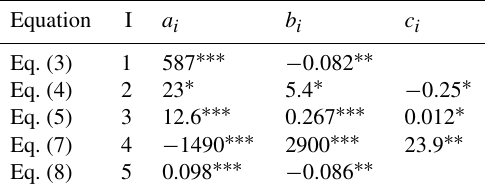
Figure 9. Surface plot shows the estimated N 2 O flux deviation (Eqs. 6, 7; Corr U, env = 0) from the exponential fit (Eq. 3) for urine patches depending on soil moisture VWC U and temperature at a depth of 5cm. The black dots indicate the conditions under which flux measurements with the FB were